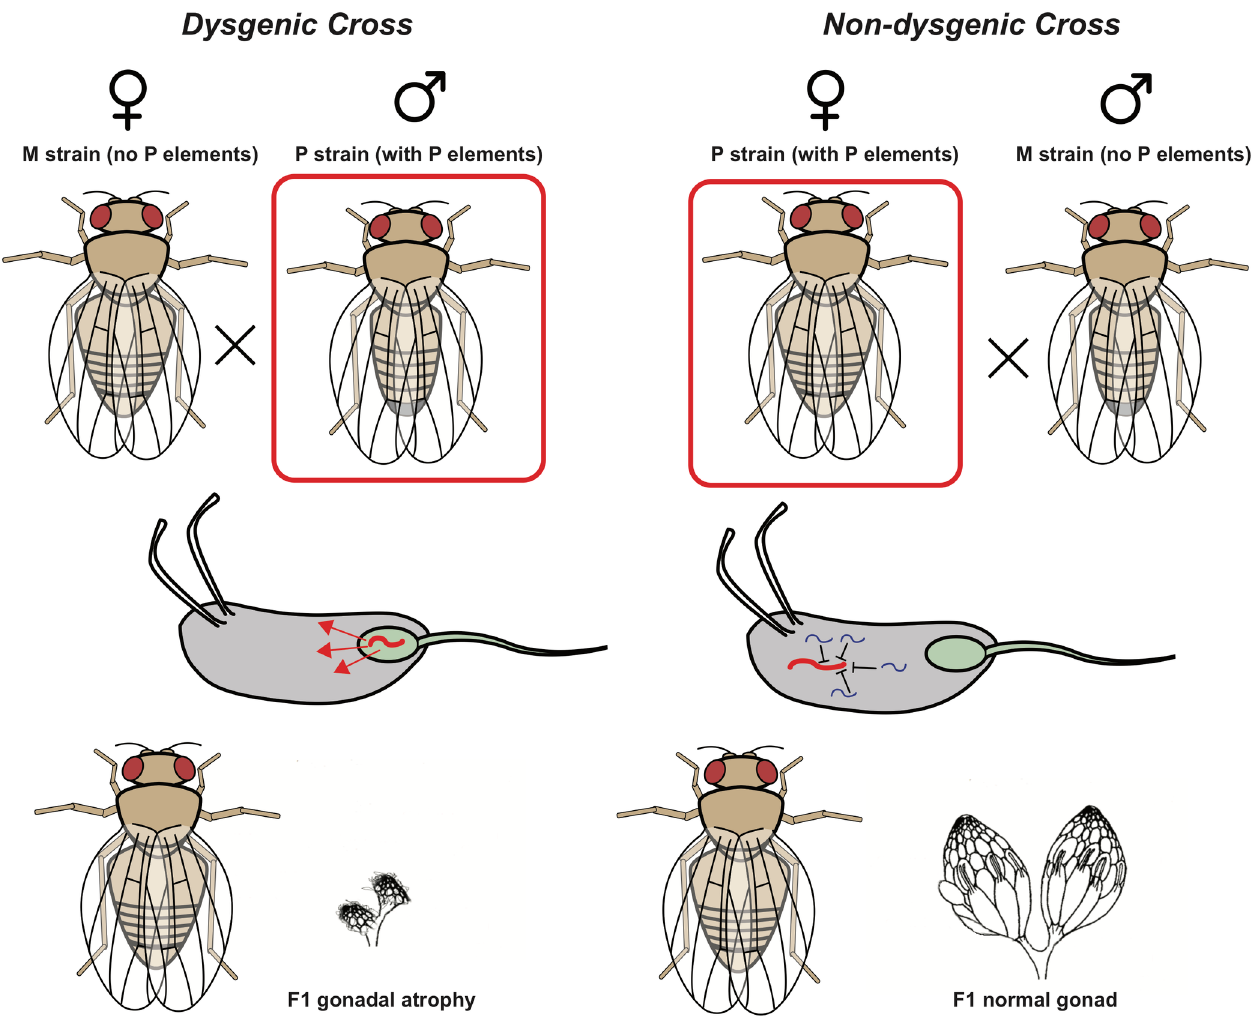
Fig 1. Maternally loaded piRNAs confer the P element cytotype and maintain P element resistance across generations. P–M dysgenesis is a syndrome of gonadal atrophy, male recombination, mutation, and chromosomal damage that occurs when P strain males are mated with M strain females. P strains carry P element transposons, and M strains do not. When P strain males fertilize the eggs of M strain females, P elements become mobilized in the germline. This mobilization causes early death of germline stem cells, and the offspring are sterile. In the reciprocal cross, when P strain females are mated with M strain males, repression of P elements is maintained, and progeny are fertile. In this cross, repression of P elements is maintained by the transmission of P element piRNAs in the female germline. In P strains, P element insertions in piRNA clusters provide a germline supply of P element piRNAs. This phenomenon constitutes a maternal effect because repression of dysgenesis can be maintained even if the progeny do not inherit the P strain alleles that are the source of piRNA. Ovary image obtained from the public domain: https://en.wikipedia.org/wiki/File:DrosophilaOvary.png . piRNA, piwi-interacting